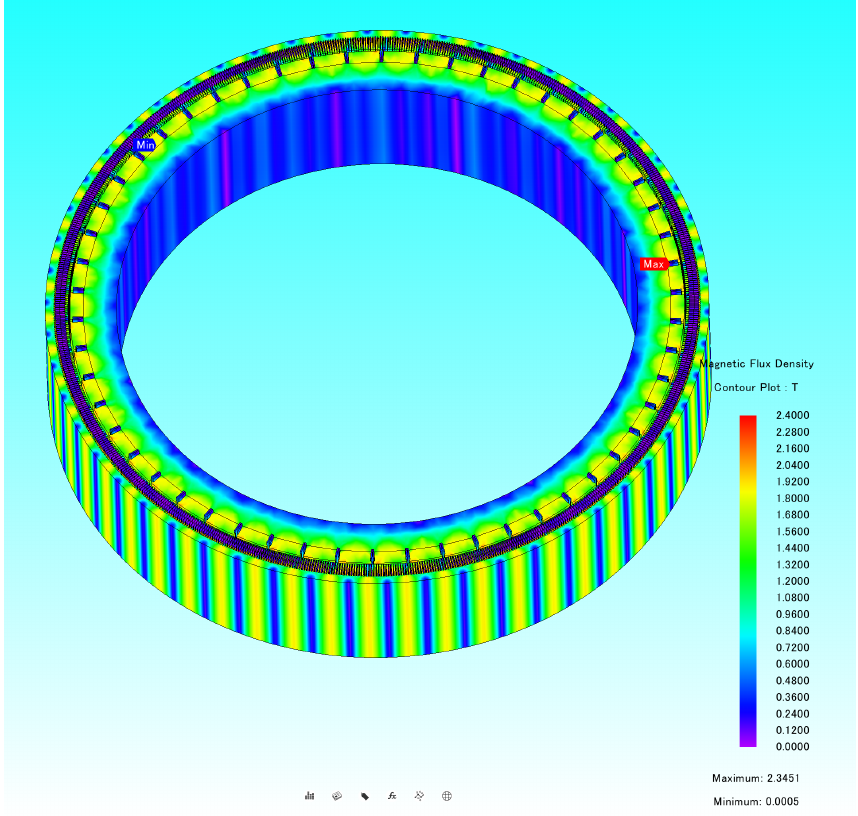
Figure 8. Magnetic induction intensity distribution